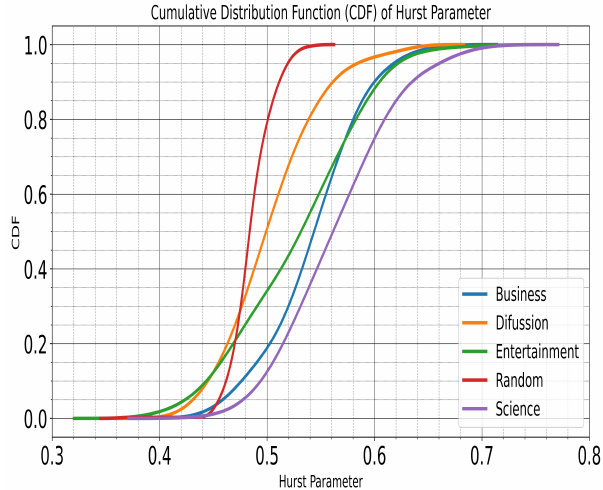
Figure 3. Cumulative Probability Functions of the Hurst parameter